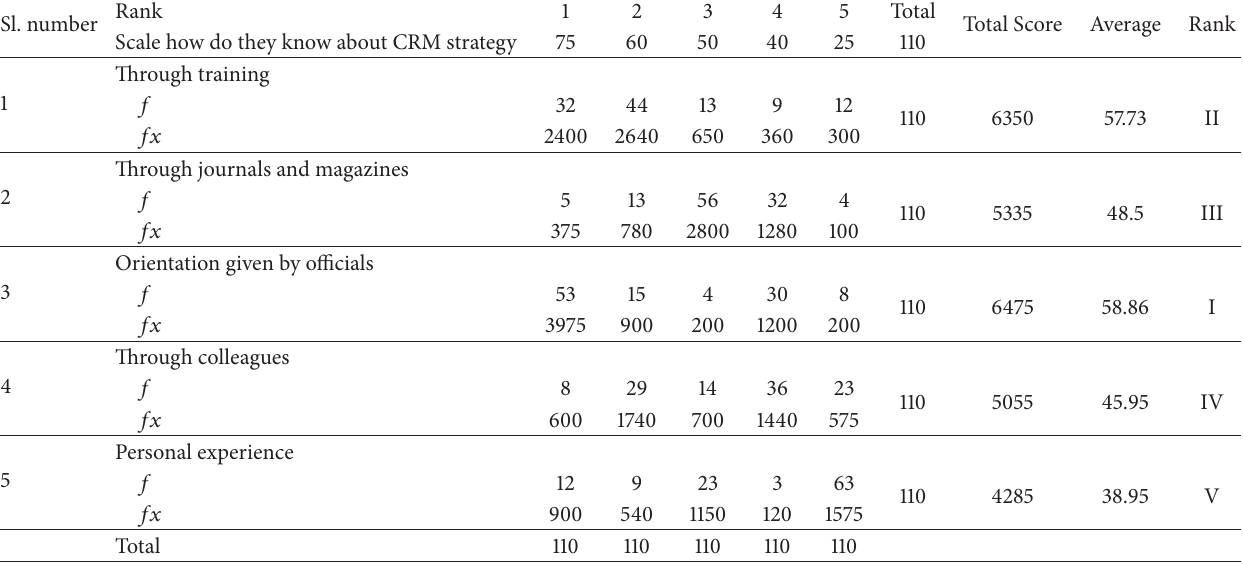
Table 1: Know about CRM strategy of banking sector.